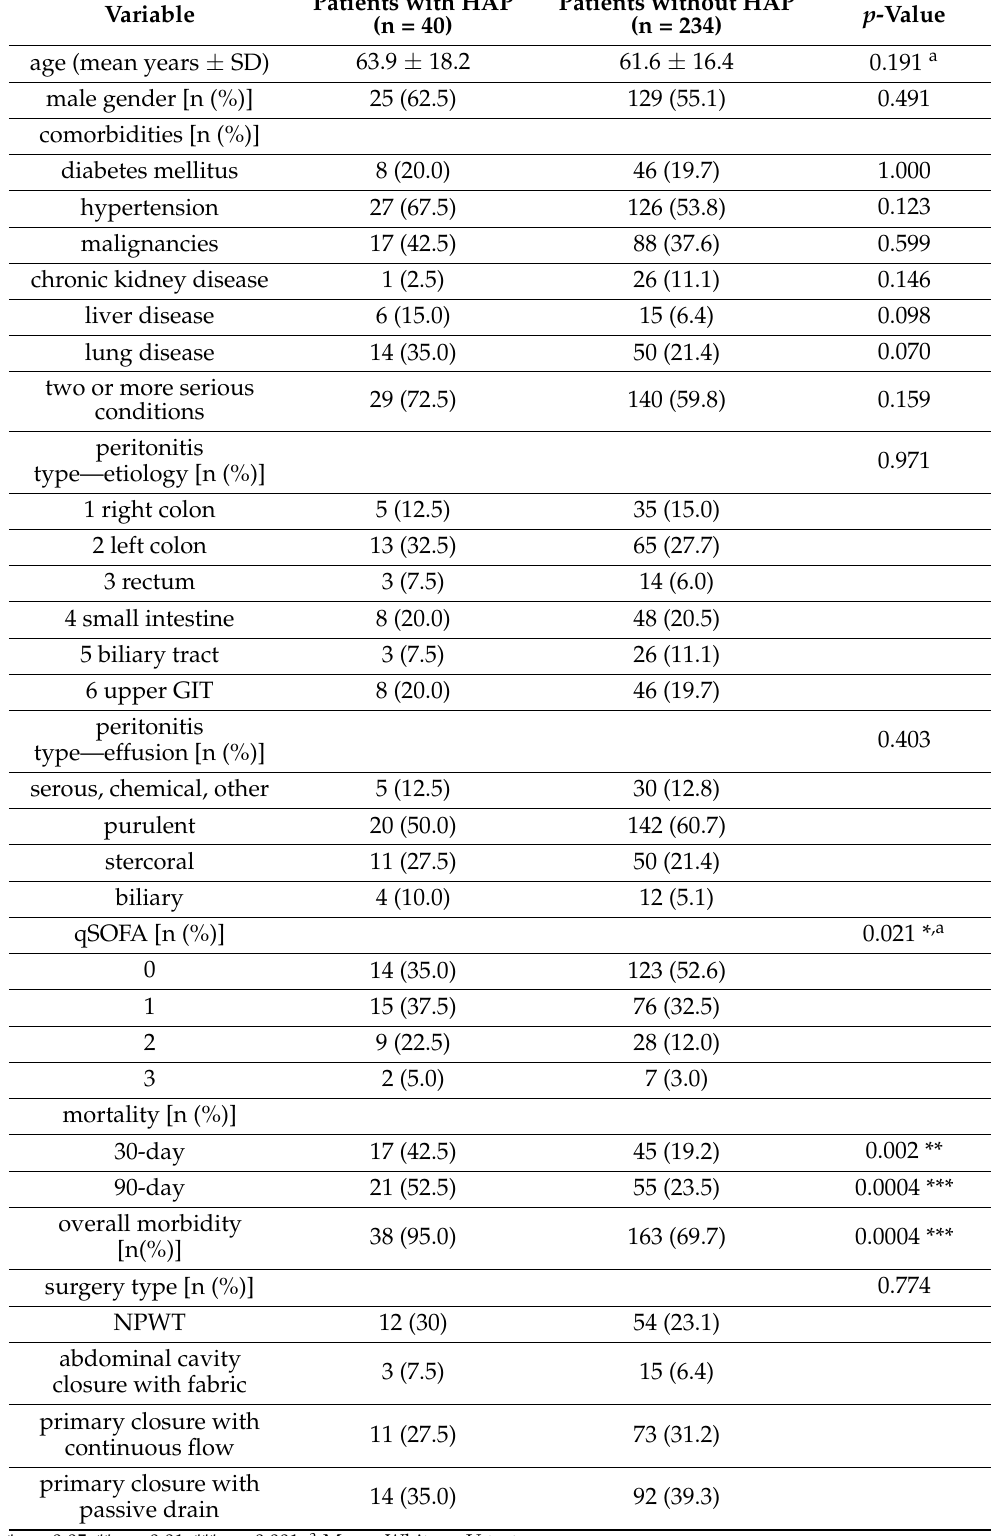
Table 1. Demographic and clinical characteristics of patients with